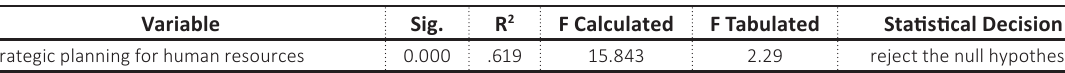
Table 6. Multiple linear regression test for H0 Variable Sig. R 2 F Calculated F Tabulated Statistical